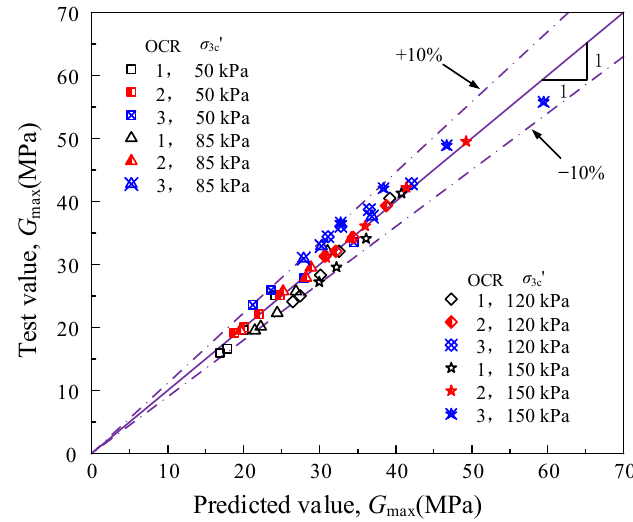
Figure 8. Comparison of G max predicted values and test values.